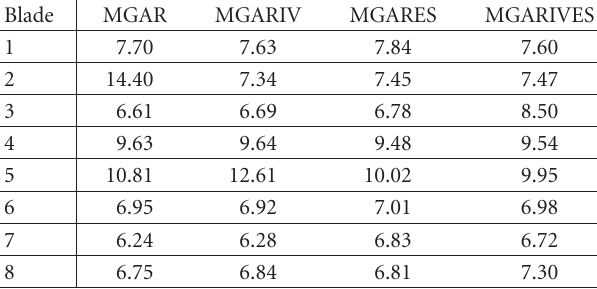
Table 7: The first blade mode peak-to-peak amplitudes (mm) re- covered by BTT methods.